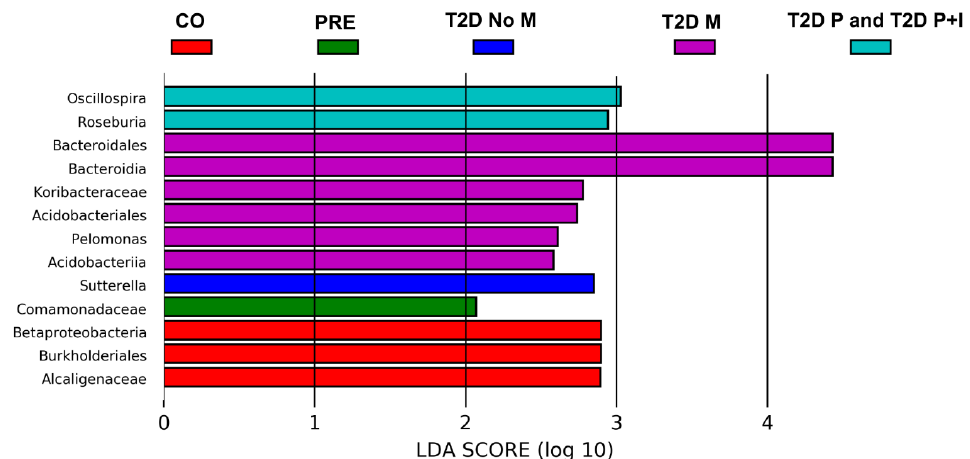
Figure 4. Graphic of the Linear discriminant analysis Effect Size (LEfSe) for the bacterial communities. The LEfSe plot shows enriched bacterial families significantly associated in five groups as follow; 1.